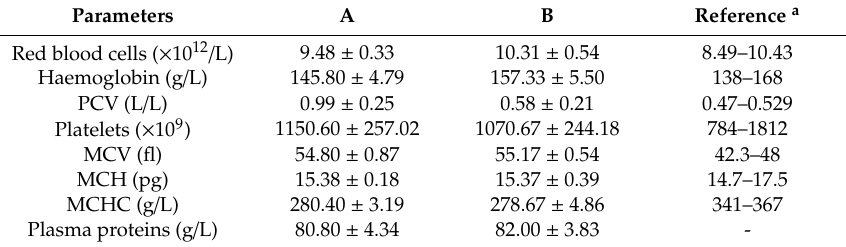
Table 2. Haematogram (mean ± SEM) of ENU-induced, leukaemic, male ICR-mice. Parameters